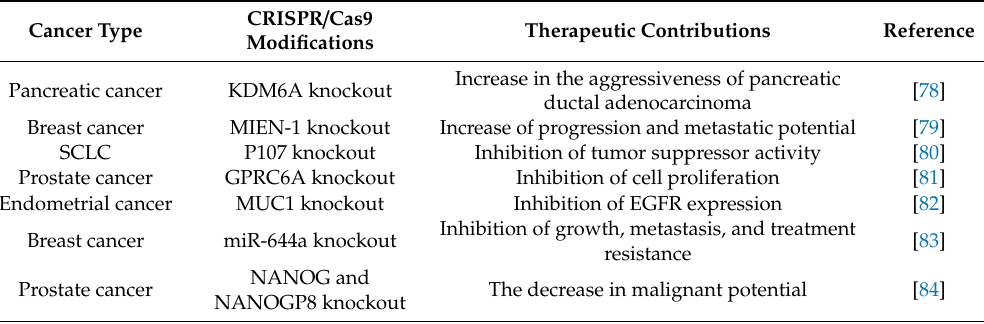
Table 2. E ff ects of cancer-specific induced mutations on metastasis and malignancy of di ff erent cancers, including examples of the benefits of CRISPR / Cas9 in the discovery of new therapeutic targets for more e ff ective cancer